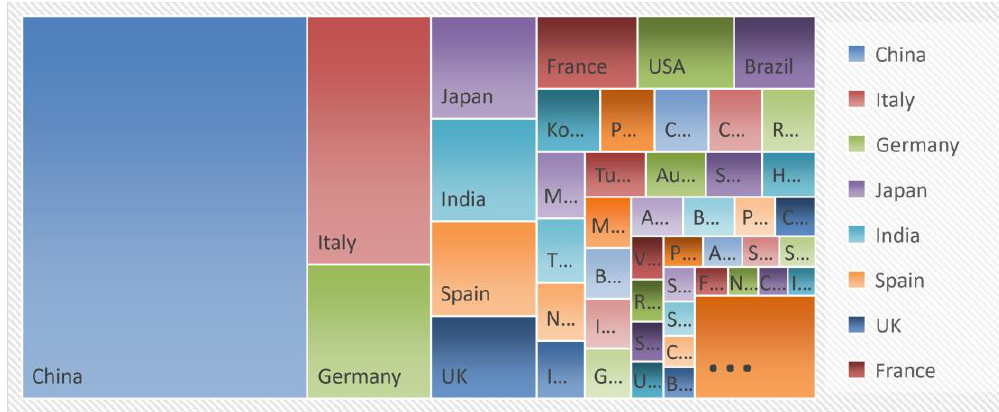
Figure 2. Visualization of countries based on number of ISO 9001 certificates issued.